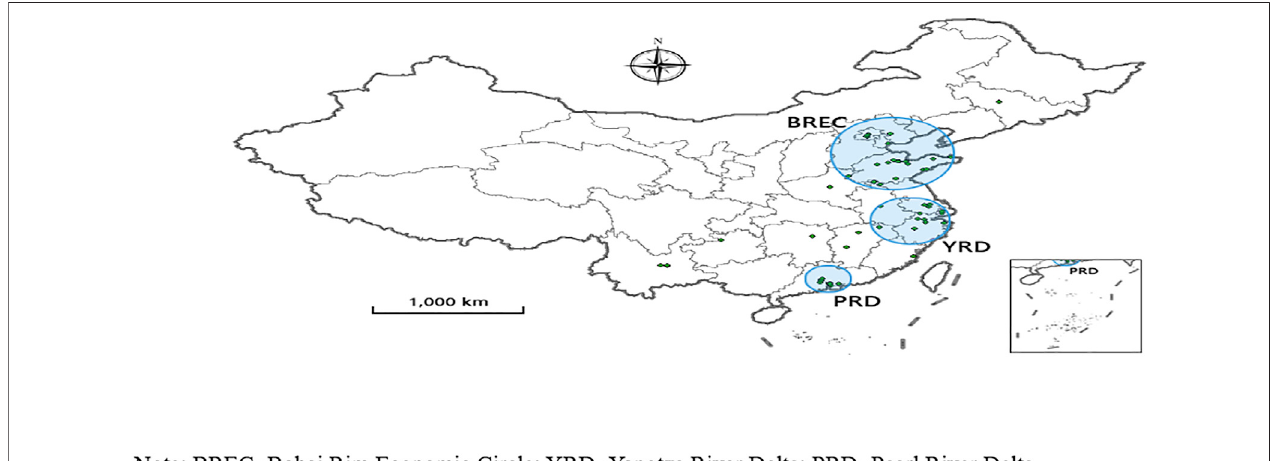
FIGURE 2 | Regional distribution statistics of samples. Note: BREC (cid:1) Bohai Rim Economic Circle; YRD (cid:1) Yangtze River Delta; PRD (cid:1) Pearl River Delta.